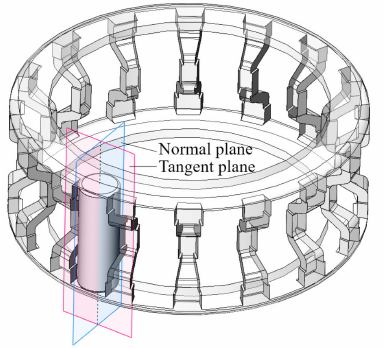
Figure 13. Schematic of the normal and tangent plane.